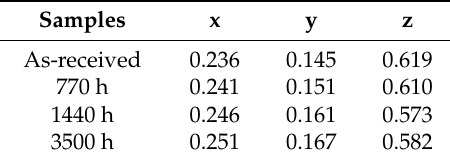
Table 2. Variation of chromaticity values with exposure time in saline water-exposed specimens.